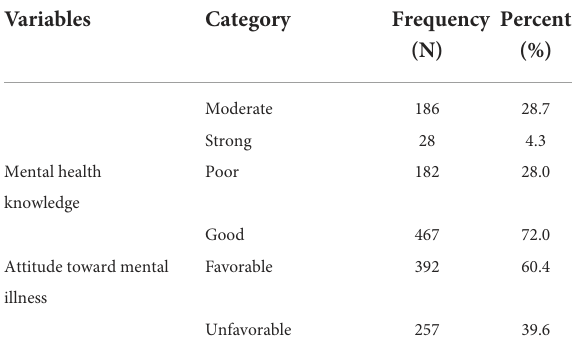
TABLE 1 Socio-demographic, clinical and psychosocial characteristics of Mattu town residents, South West Ethiopia, 2022 ( n =